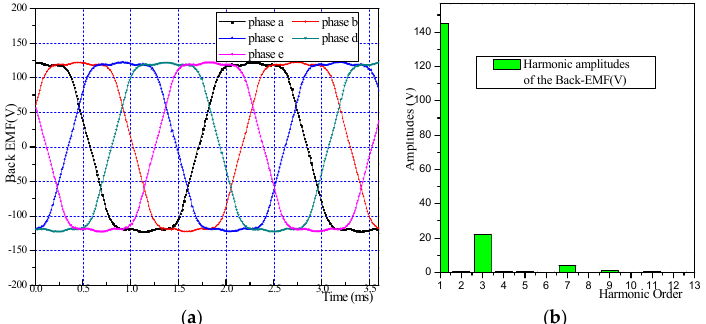
Figure 3. The no ‐ load back electromotive force (EMF) in series drive mode ( a ) waveform and ( b ) harmonic component analysis.